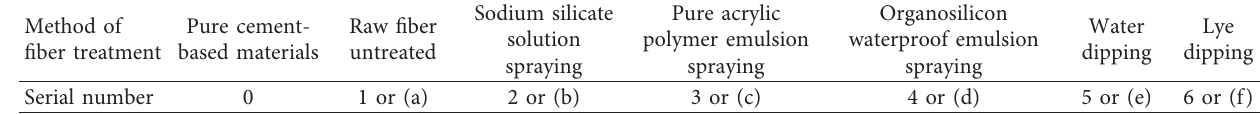
Table 4: The meanings of test serial number and test code.